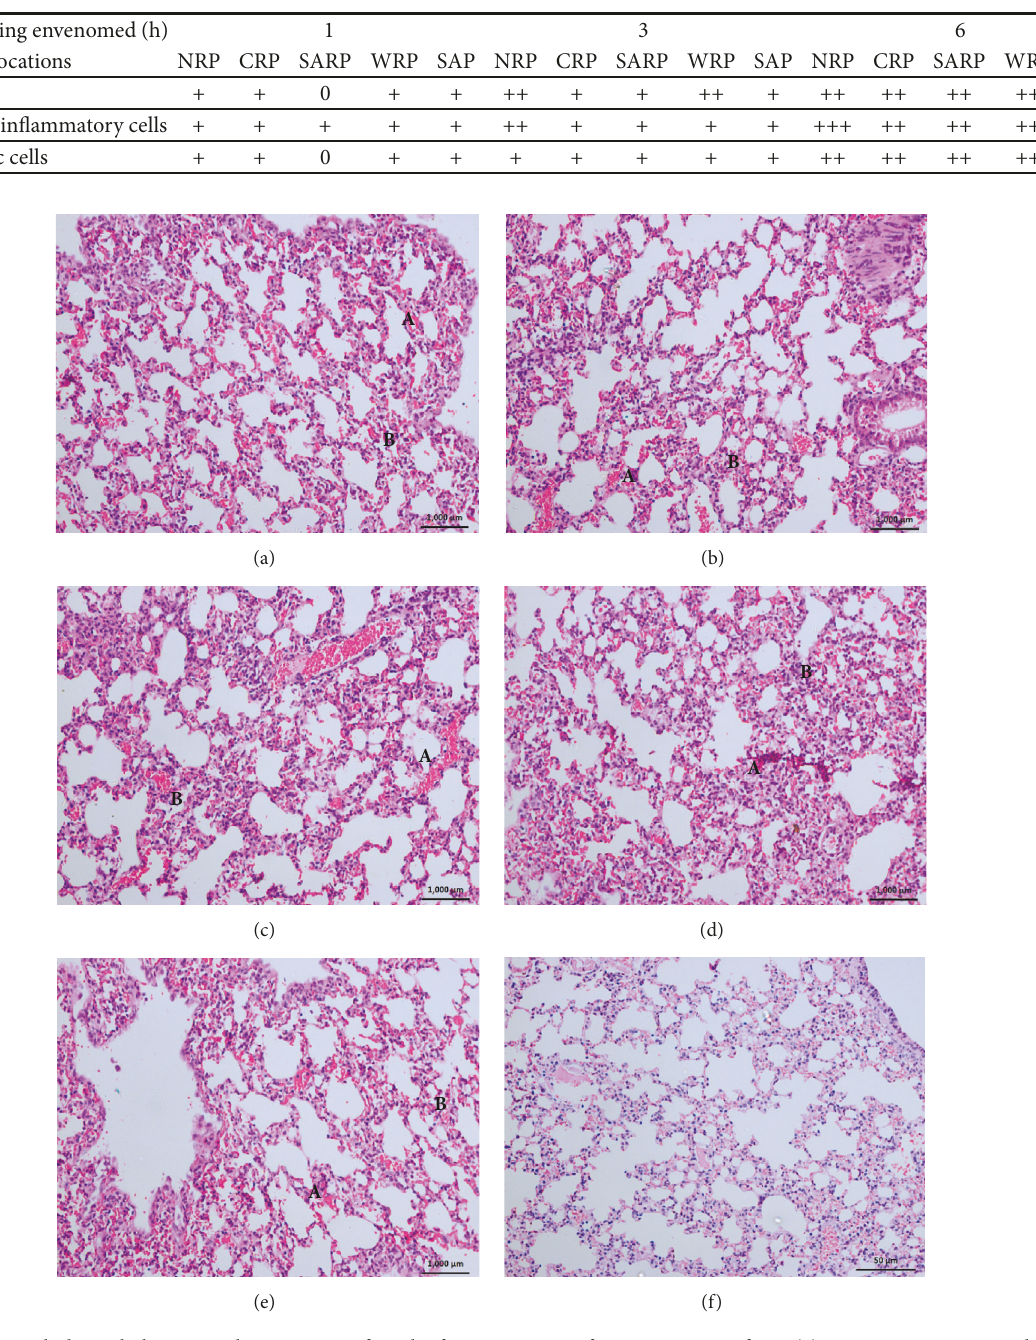
congestion was 0.2 mg/Kg for all regional venom